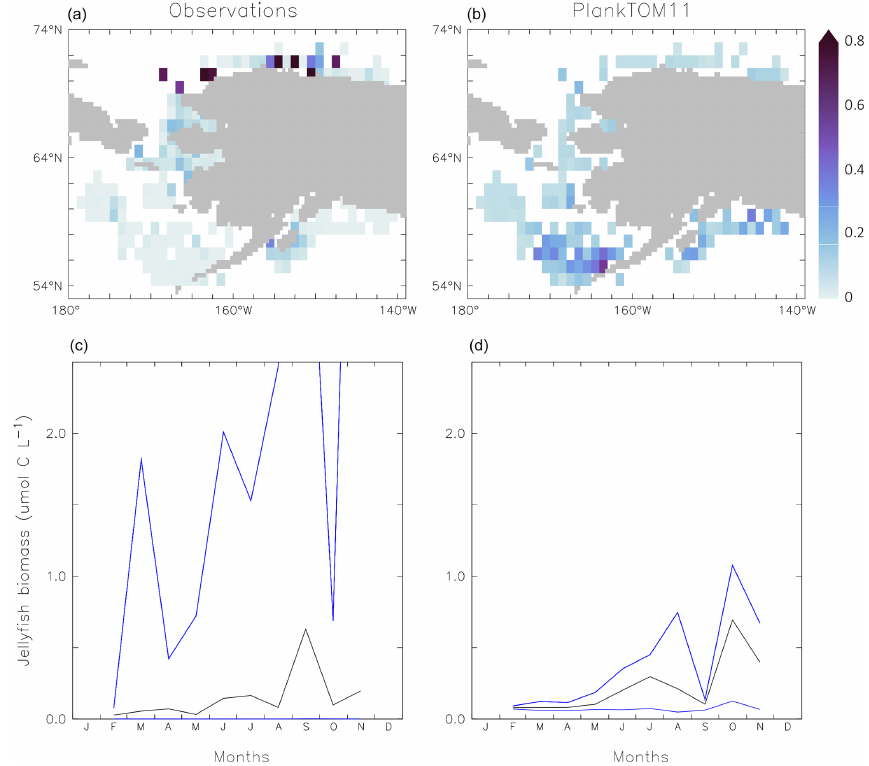
Figure 7. Carbon biomass of jellyfish (µmolCL − 1 ) from MAREDAT observations (a, c) and PlankTOM11 (b, d) for the coast of Alaska (the region with the highest density of observations). Panels (a, b) show the mean jellyfish biomass, and panels (c, d) the seasonal jellyfish biomass, with the monthly mean in black and the monthly minimum and maximum in blue. Observations and PlankTOM11 results are for 0–150m, as the depth range where > 90% of the observations occur. No observations were available for January or December.